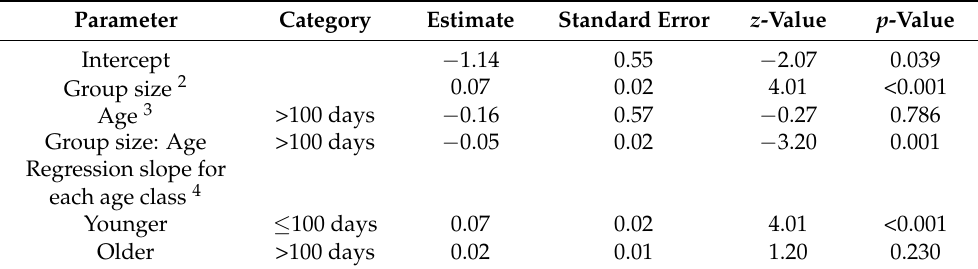
distribution. 4 Increase in BCoV-positive swab samples (%) with increasing mean group size.